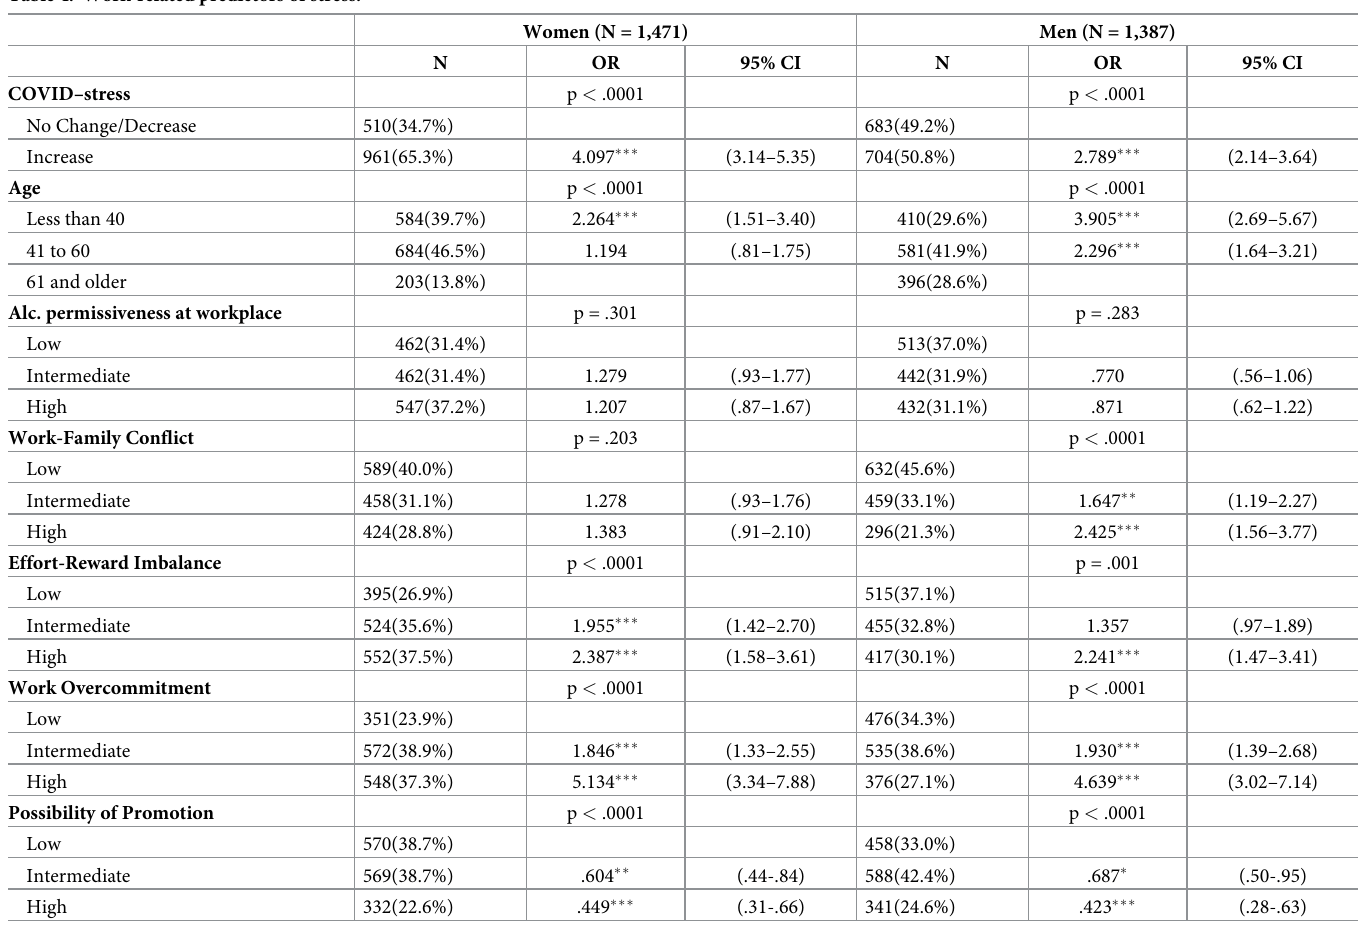
Table 4. Work-related predictors of